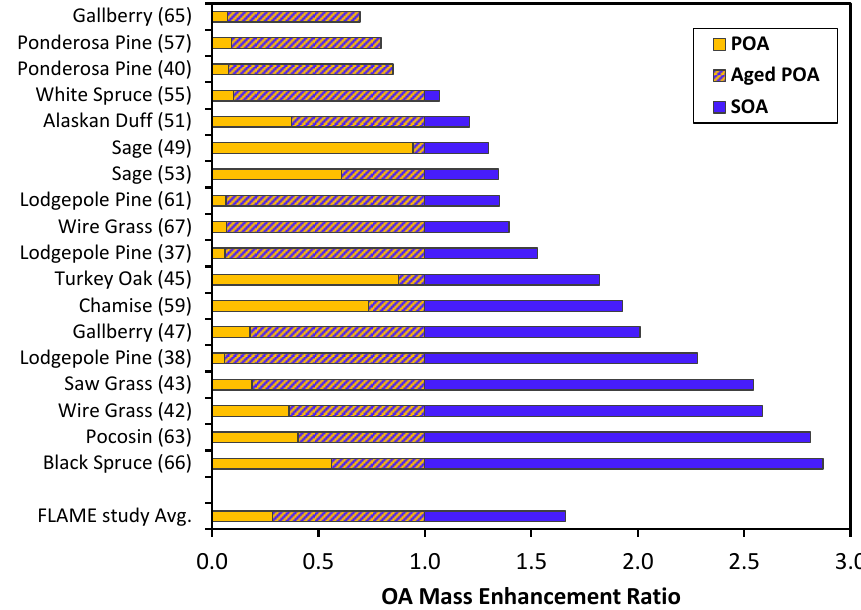
Fig. 8. OA mass enhancement ratios measured at the end of each experiment (burn number in parentheses), as in Fig. 3. Colored portions of each bar indicate the contribution of POA (assuming levoglucosan is an inert tracer), aged-POA and SOA, as described in the